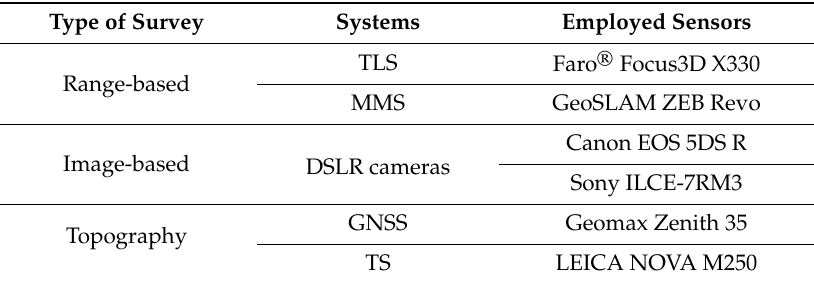
Table 1. Geomatics instruments used in the data acquisition